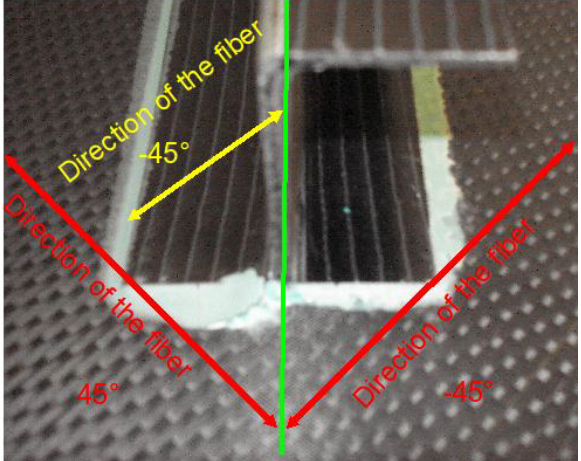
Figure 6: 153 Y-direction sensors [10].